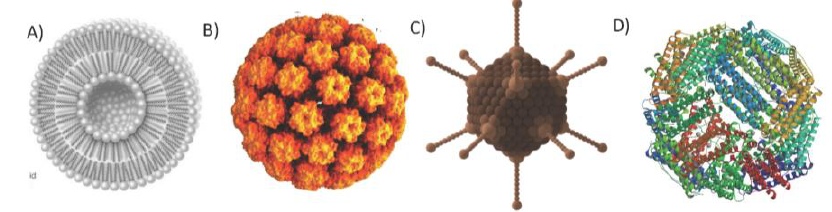
Figure 1. Nanoparticles. ( A ) Liposome: schematic representation of a phospholipidic liposome; ( B ) VLP derived from HPV virus, PDBID: 1DZL; ( C ) Viral vector: schematic representation of viral adenovirus.; ( D ) Self-assembled proteins: X-ray structure of ferritin PDBID: 2X17. Protein Data Bank Identification (PDBID).